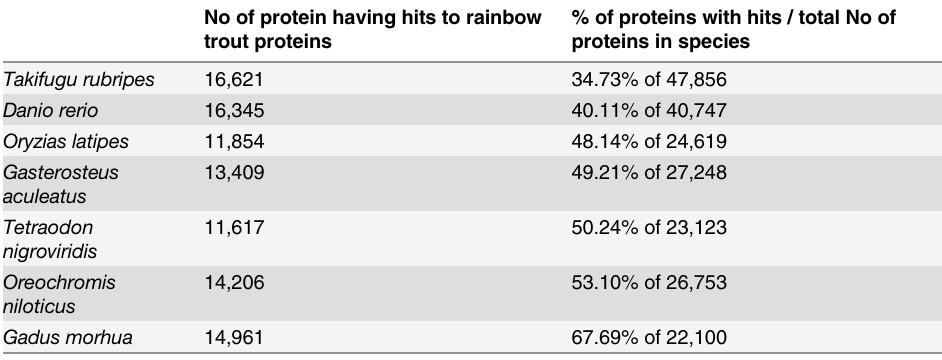
Table 3. Summary of BLASTx search analysis of rainbow trout sequences against different model fi sh species with known reference genomes. No of protein having hits to rainbow trout